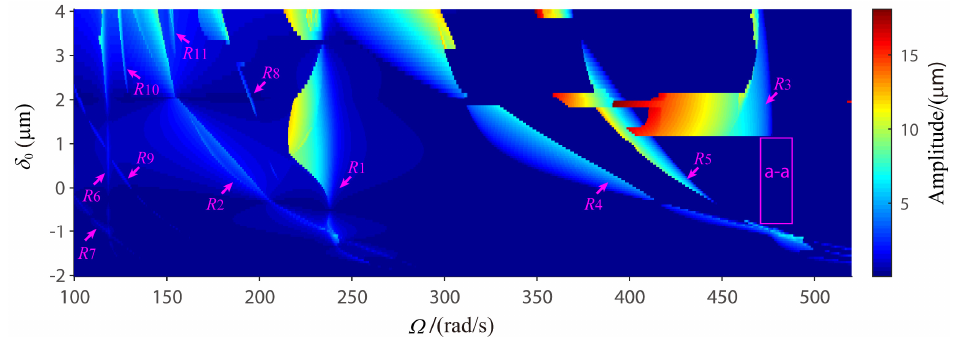
Figure 12. Power spectra of response amplitude around the bearing clearance-free operations.